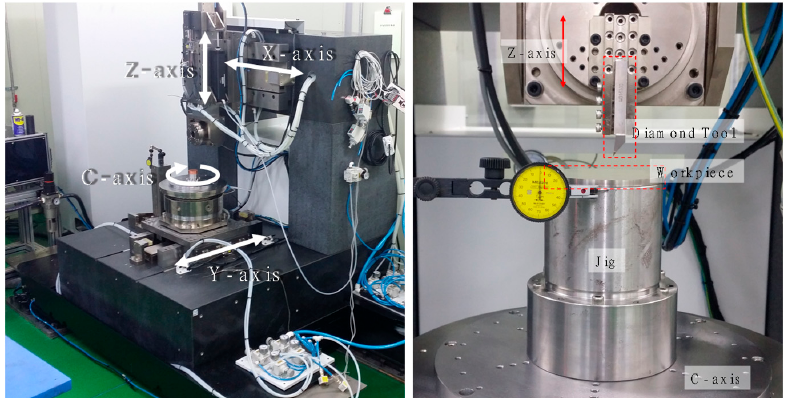
Figure 3. Precision machine tool (4-axis with air bearing) and experimental setup (run-out correction using the indicator and height correction using a jig).